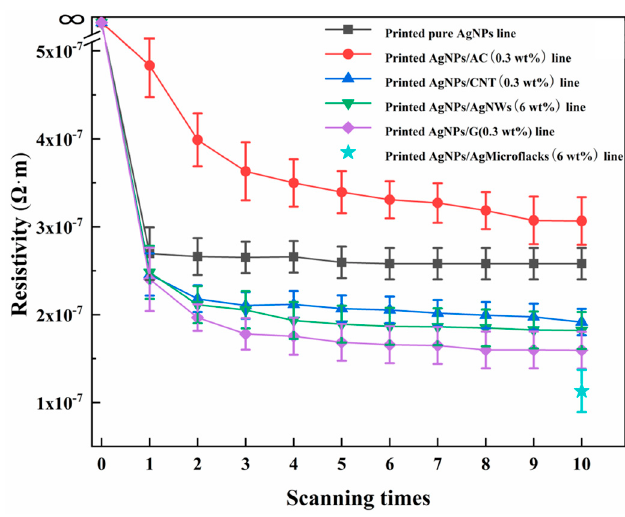
Figure 4. The resistivity as a function of laser scanning times.